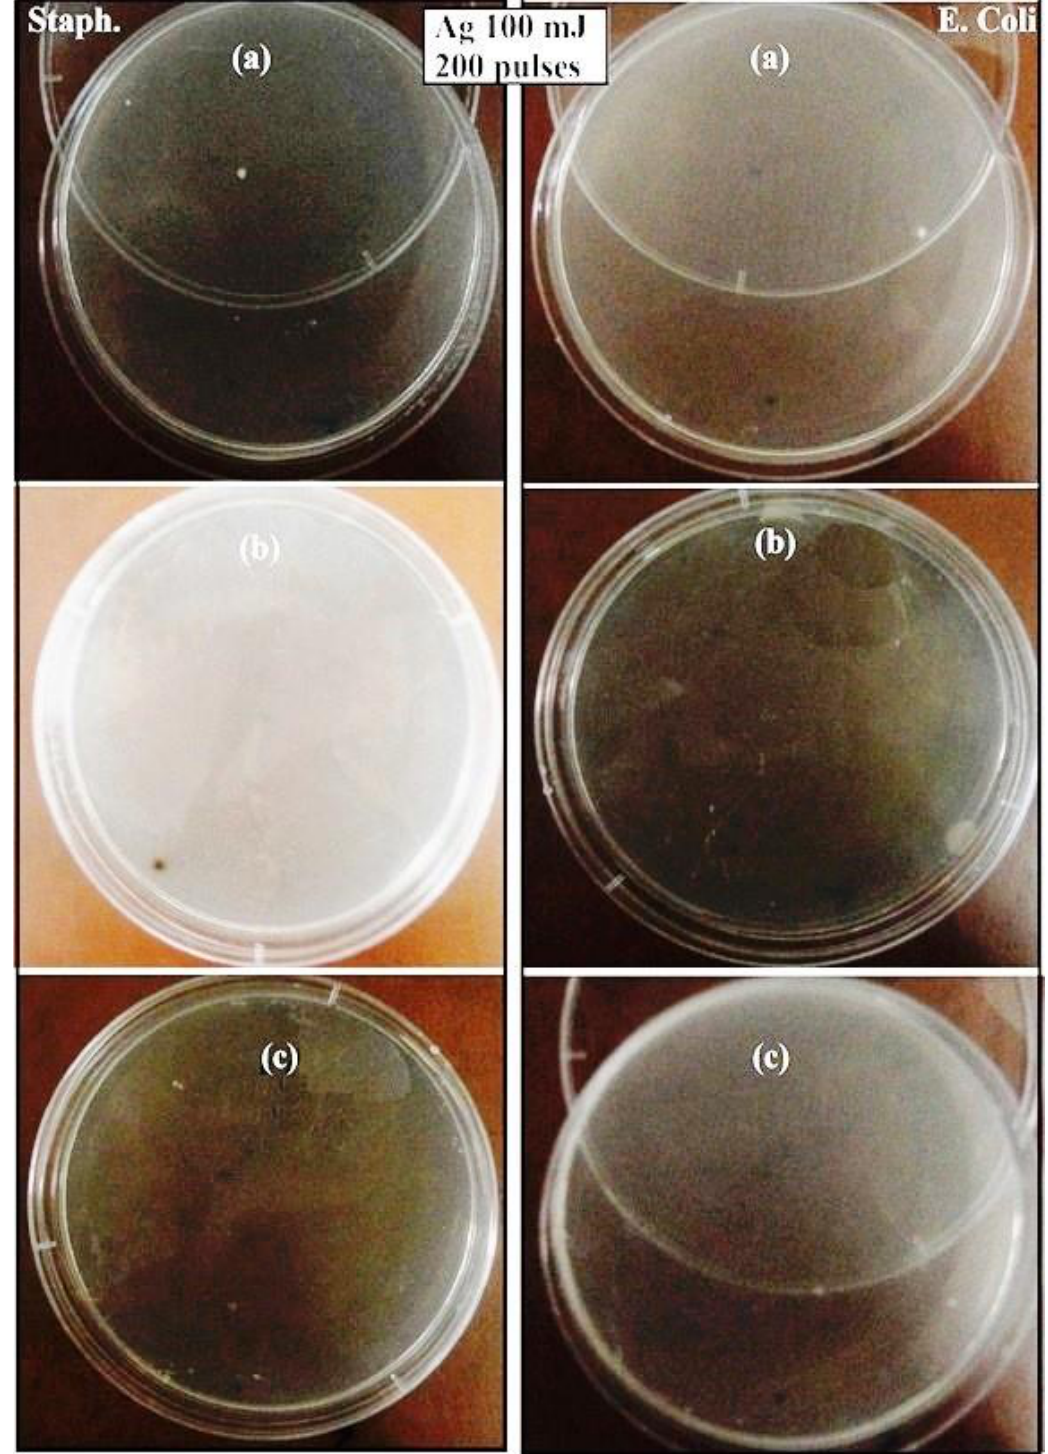
Fig.8: Killing ratio bacteria with (Ag) with energy (100)mJ with (200)pulses with different concentration (MIC) for every type from